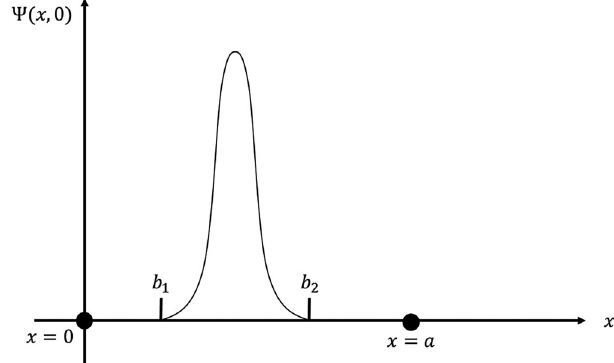
FIG. 2. A possible wave function for a finite square well. Students in an upper-level quantum mechanics course were asked if it is a possible wave function for a finite square